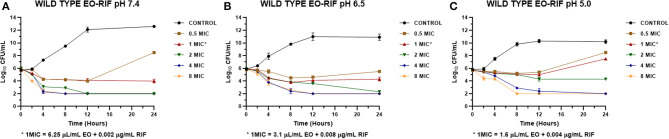
Time-kill curve for combinations of essential oil/rifaximin on Staphylococcus aureus wild types (n = 3, using the mean of triplicates for each strain) at pH 7.4 (A), 6.5 (B), and 5.0 (C) [minimum inhibitory concentration (MIC) = 0.032 μg/mL].